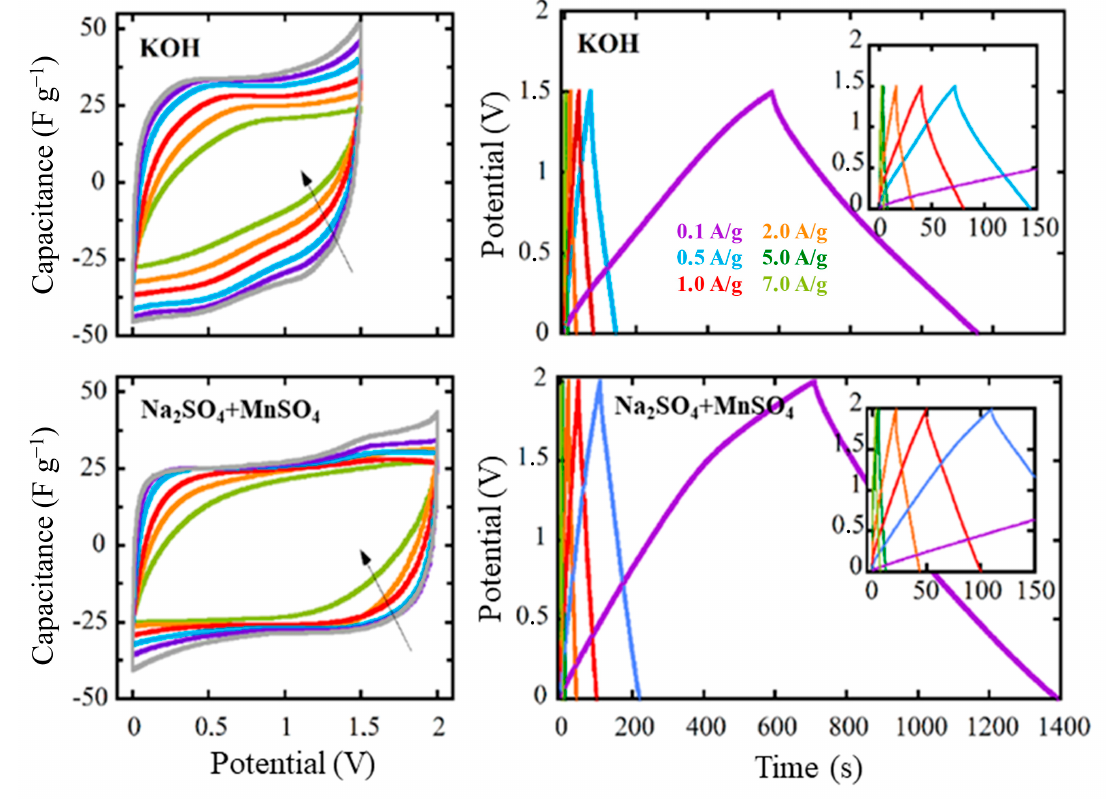
Figure 7. CVs at 5, 10, 20, 50, 100 and 200 mV s − 1 —scan rates ( left ) and GA curves ( right ) of final systems in both electrolytes.